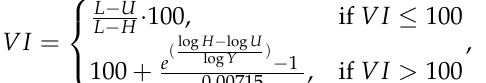
(Figure 7) performing measurements in accordance with PN-EN ISO 12185:2002. The accuracy of the measurement temperature setting is 0.02 ◦ C, while the accuracy of density measurement is 5 · 10 − 5 g/cm 3